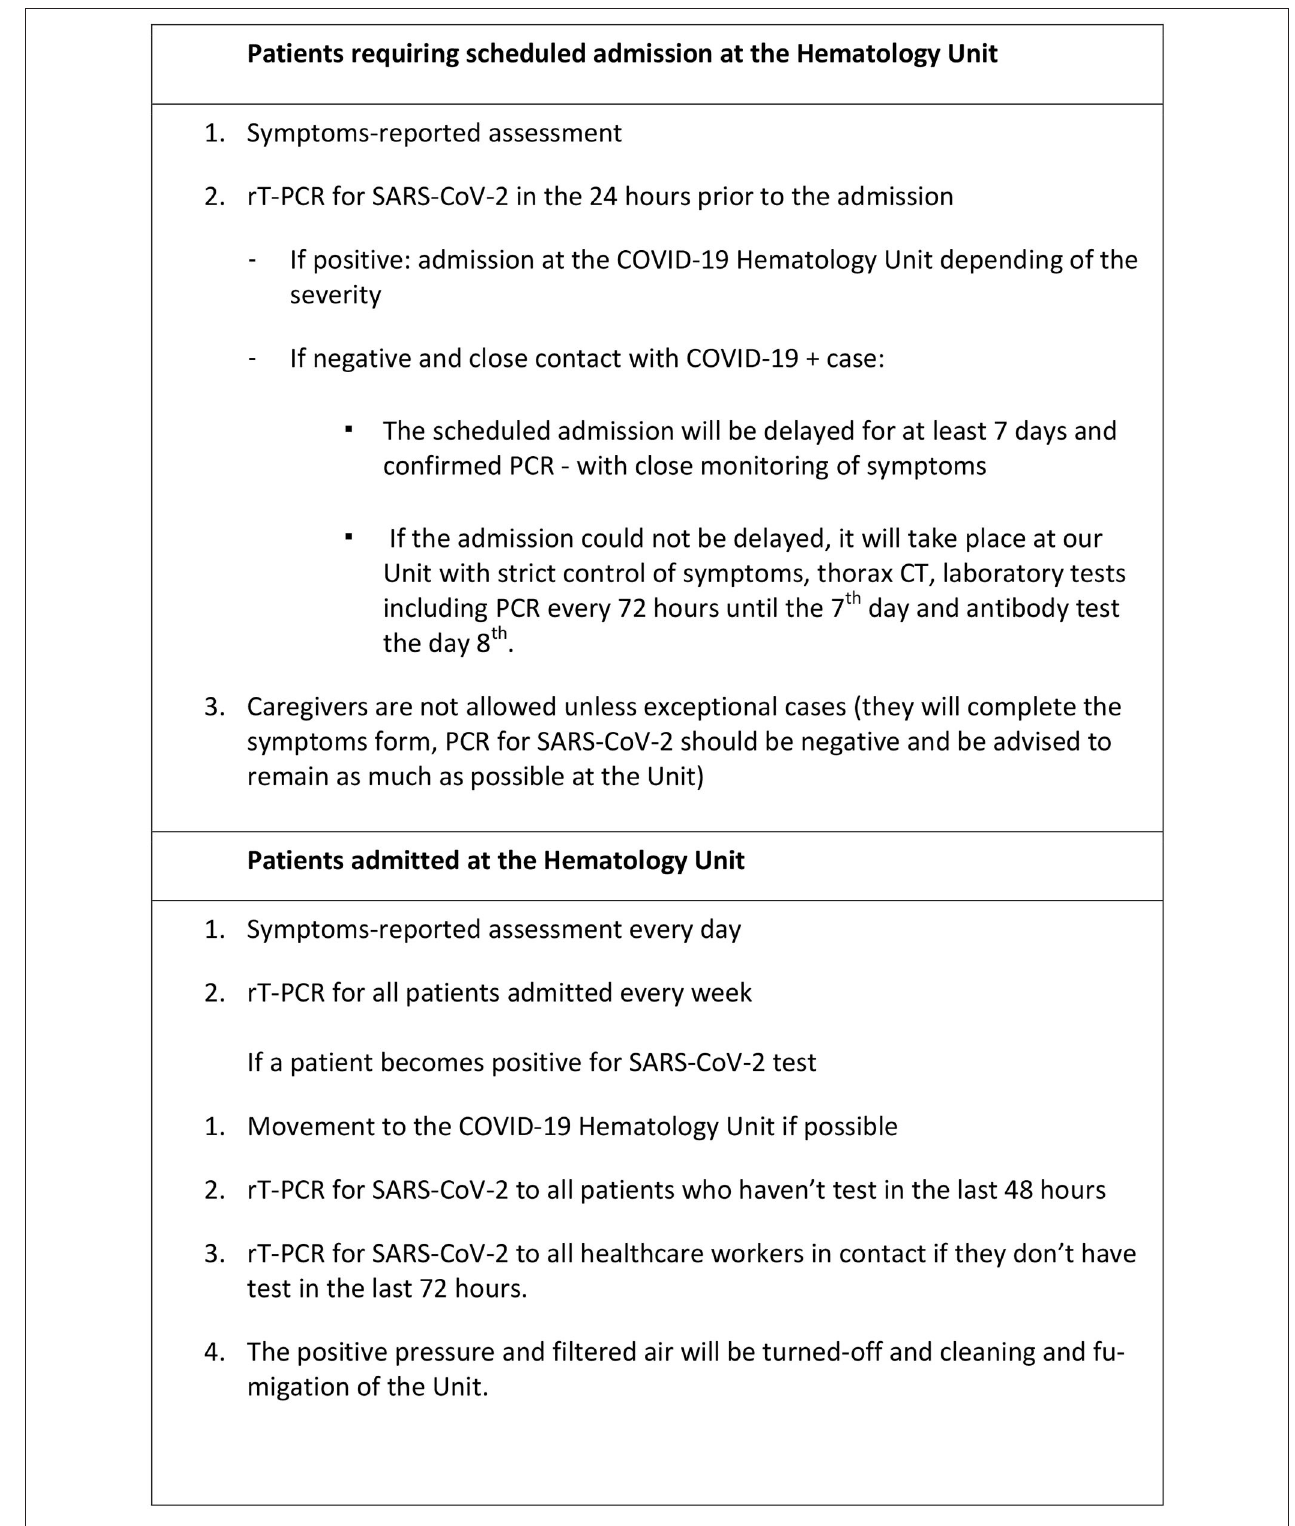
FIGURE 4 | General measurements to maintain the Hematology Unit as a “COVID-19 free island” in the pandemic.